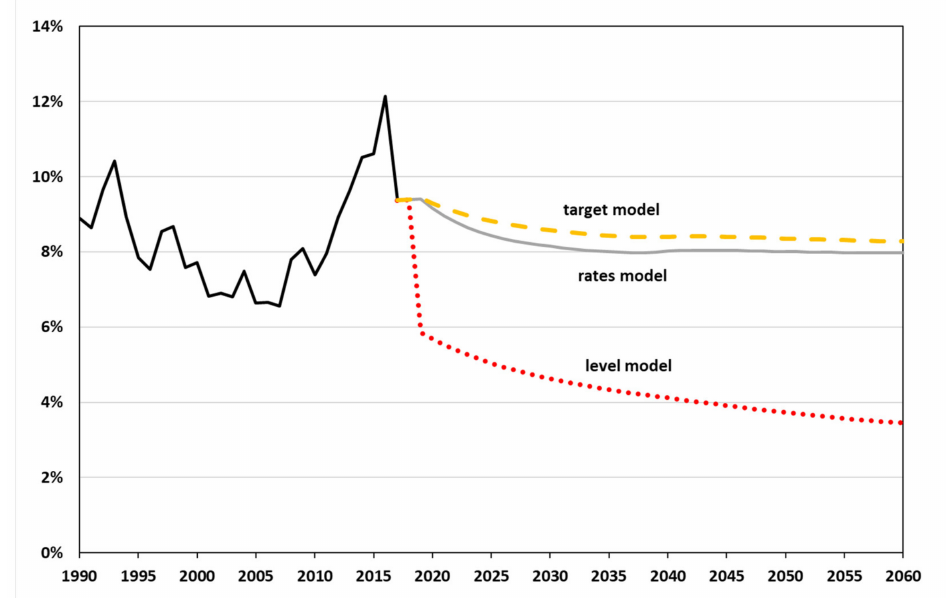
Figure 3. Emigration rate of the non-German population until 2060 (as %)—simulation results from 2019 onwards. (Sources: [56,57]; own computation and